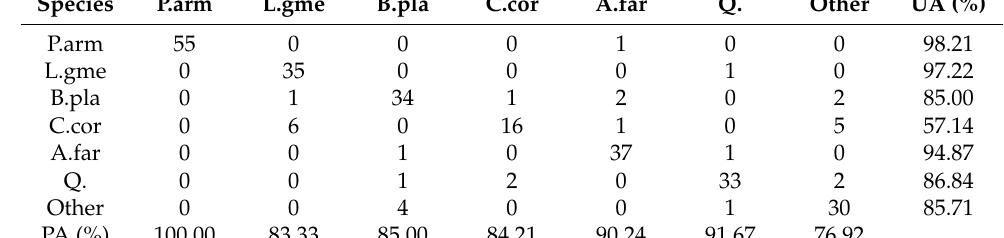
Table 11. Classification confusion matrix of tree species at altitude 1800 m based on XGBoost.